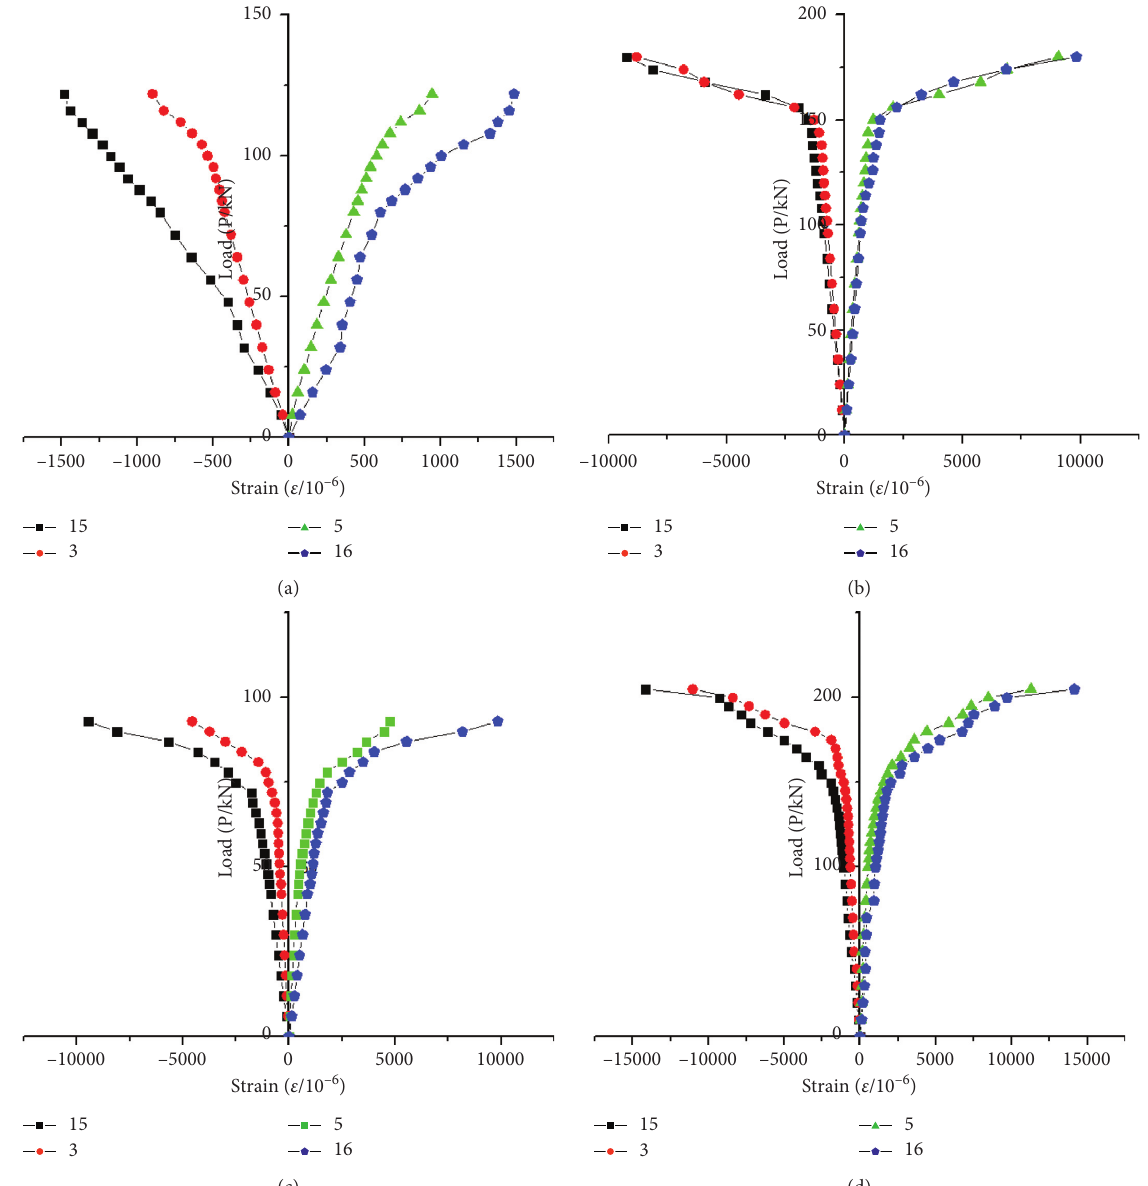
Figure 13: Load-strain relationship curve of midspan section. (a) L-1, (b) L-2, (c) L-3, (d)